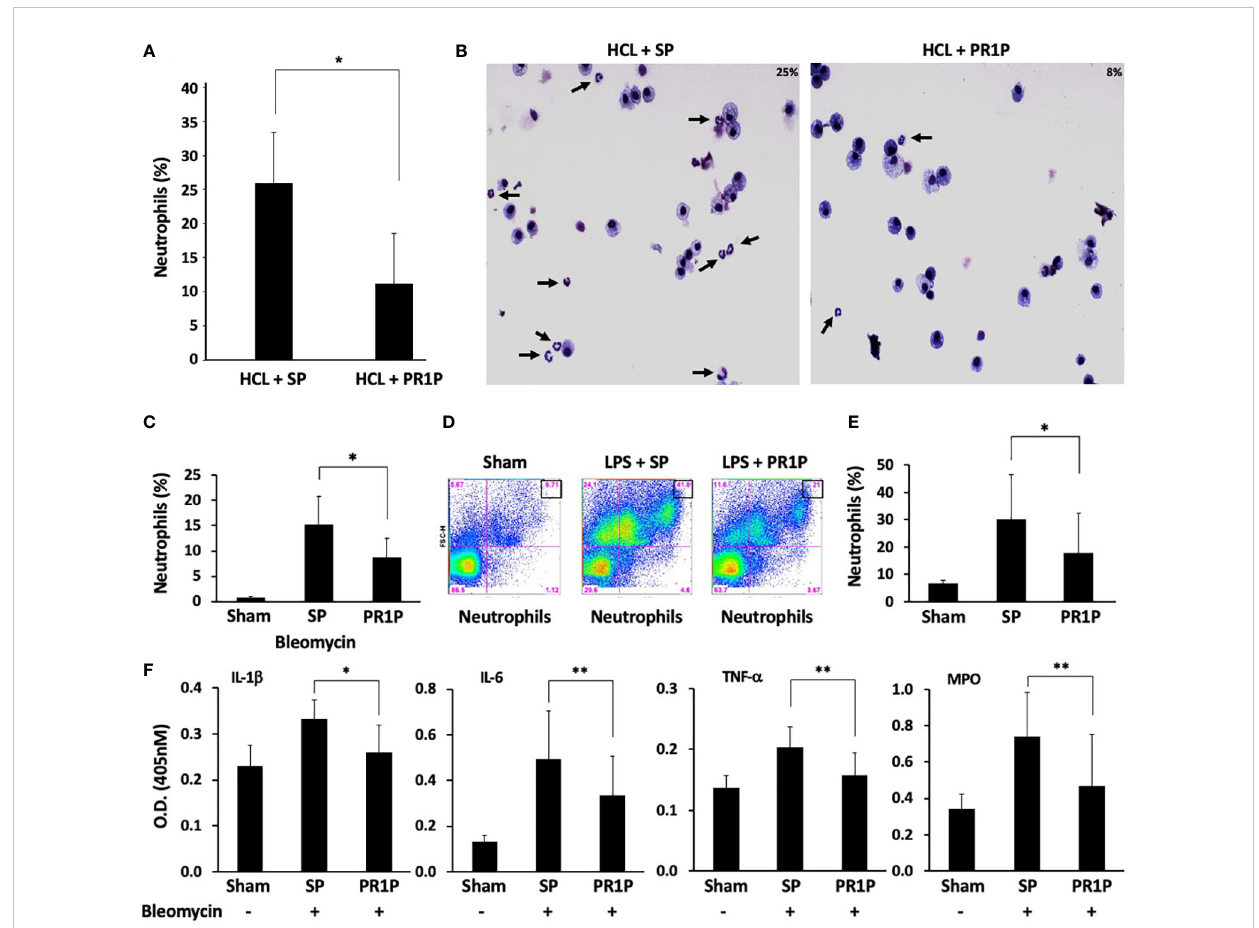
FIGURE 2 PR1P inhalation reduces neutrophil migration into lungs and lung in fl ammation following bleomycin, LPS and HCL injury in mice. (A) Bar graph showing percentage of neutrophils present (% of total cells in region of interest (ROI)) in BALF following IT administration of acid (HCl) and daily inhalation of PR1P or scrambled peptide (SP). n=8 repeated 3 times. *p<0.023 (B) Representative Diff-Quik stained cells from murine BALF described in (A) showing reduced neutrophils (black arrows) following PR1P treatment (25%) compared to SP (9%). (C) Bar graph showing percentage of neutrophils present (% of total cells in ROI) in BALF following IT administration of Bleomycin and daily inhalation of PR1P or scrambled peptide (SP). n=7 repeated 3 times *p<0.02. (D) Representative FACS analysis of cells from whole lung digests from mice treated with PR1P or SP after LPS injury showing reduced presence 24h after injury of neutrophils following PR1P inhalation. (E) Bar graph showing quanti fi cation of neutrophils (% of total cells) in whole lung cell digests from FACS experiments described in (D) n=8, repeated 3 times *p<0.02. (F) Bar graph showing quanti fi cation (Optical Density (OD) at 405 nm) of indicated cytokines or myeloperoxidase (MPO) activity in BALF following bleomycin injury in experiments described in (A) All data are mean + SEM. n=5. *p<0.004,